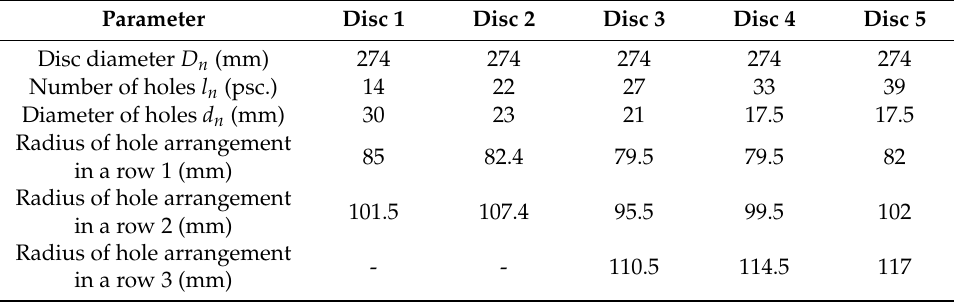
Table 1. Structural characteristics of a five-disc grinder working discs RWT-KZ5.